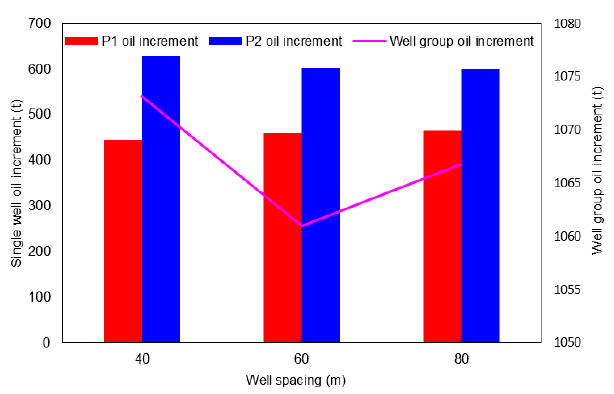
Figure 19. Oil increment of different well spacing.